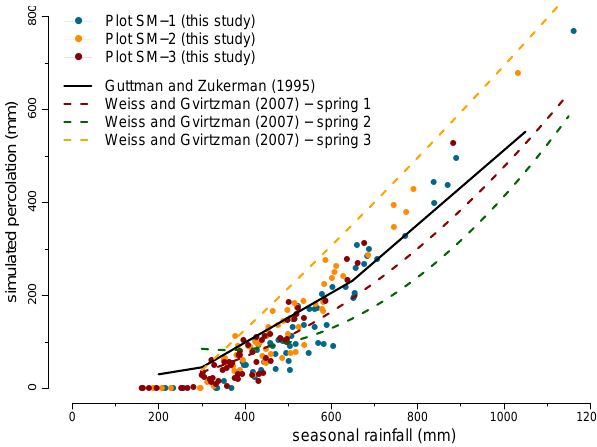
Figure 12. Simulated seasonal percolation at the plot scale (SM-1, SM-2, SM-3) for the period 1951–2013 in comparison to rainfall– recharge relationships for the carbonate aquifer (Guttmann and Zukerman, 1995) and three small karst springs emerging from lo- cal perched aquifers (Weiss and Gvirtzman,